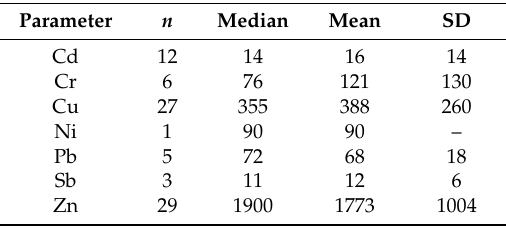
Table 6. Median annual runoff loads (g/ha) for all highway sites. For Pb, only data measured in the 21st century was